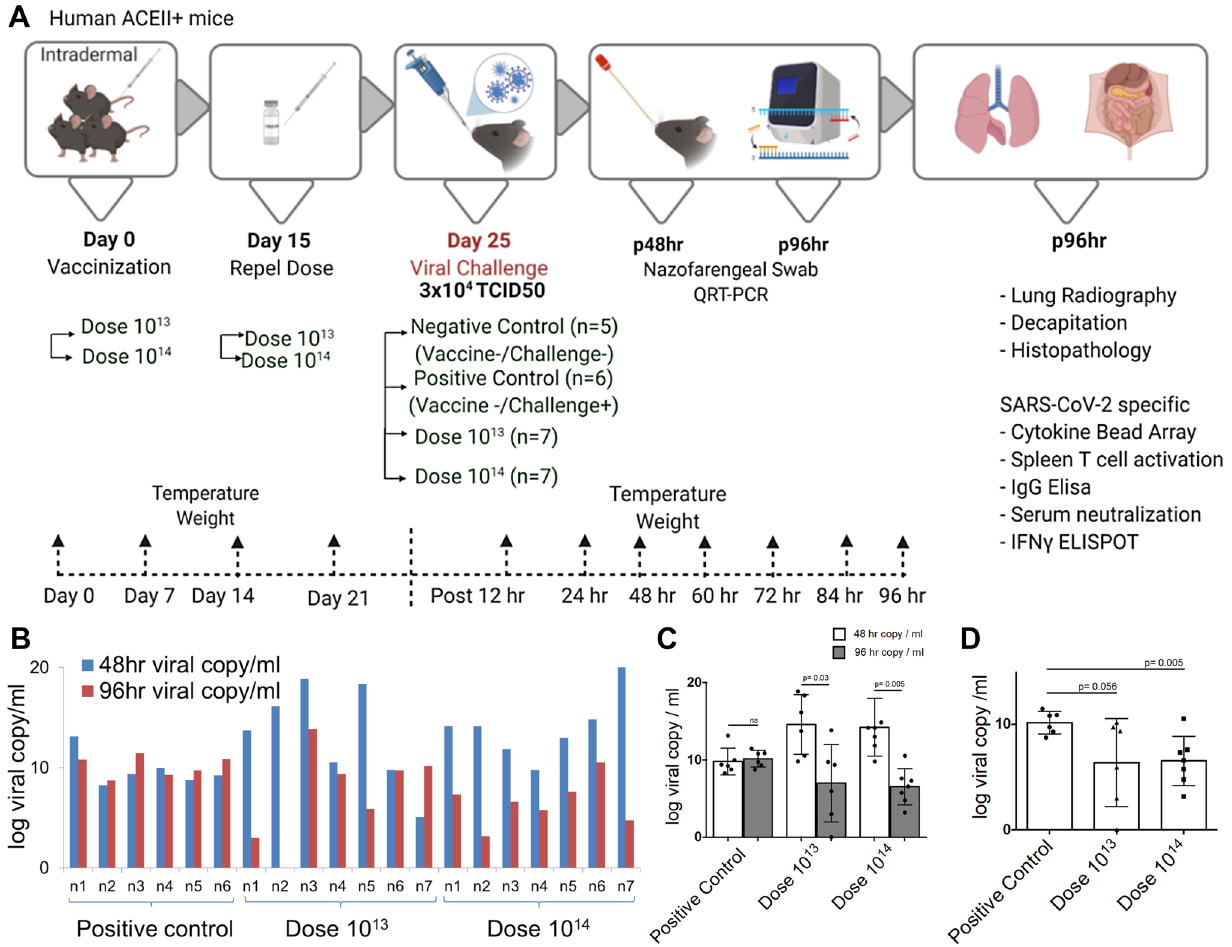
Figure 3. Challenge test with OZG-38.61.3 vaccinated humanized ACEII+ mice. ( A ) Representation of in vivo experimental setup of the challenge test. ( A ) Mice were allocated into 4 groups, a negative control group (n = 5), a positive control group (n = 6), and 2 different intradermally vaccinated groups (dose 10 13 and dose 10 14 , n = 7 per group). A booster dose of dose 10 13 and dose 10 14 vaccine was administered on day 15. After 25 days of vaccination, the mice were intranasally infected with a 3 × 10 4 TCID50 dose of SARS-CoV-2. Biopsy samples, spleen T cells, and serum were collected after euthanization at 96 h. ( B ) The bar graph showing SARS-CoV-2 viral RNA copy number in log scale per ml of the nasopharyngeal samples collected from each mouse at 48 h and 96 h post-challenge that were either vaccinated with dose 10 13 (n = 7), dose 10 14 (n = 7), or without vaccination group (positive control; n = 6). ( C ) The bar graph shows the mean value of viral RNA copy in log scale per ml at 48 h and 96 h post-challenge. ( D ) The bar graph showing a comparison of viral RNA copy number at 96 h between vaccinated and positive control